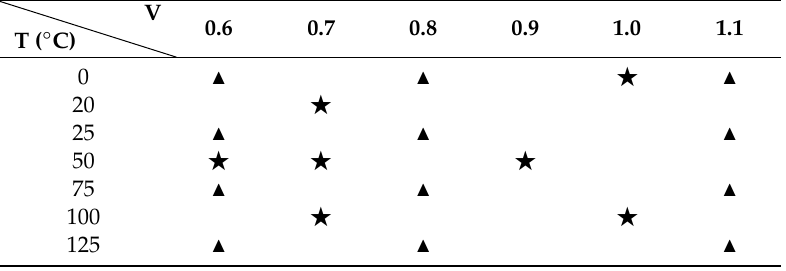
Table 3 Training and predicted corners. Table 3. Training and predicted corners.